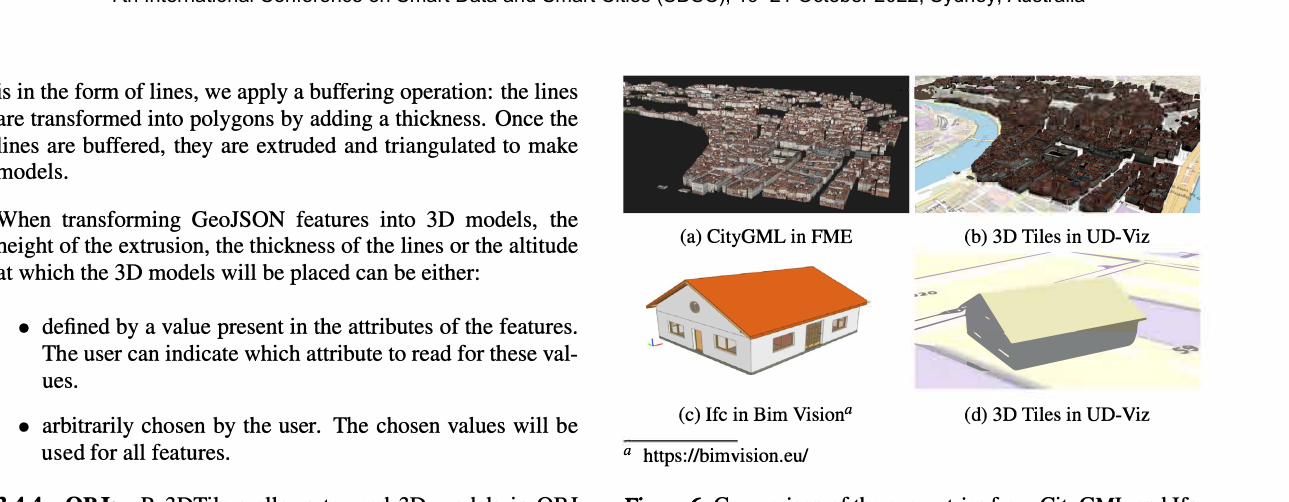
Figure 6. Comparison of the geometries from CityGML and Ifc with the geometries transformed as 3D Tiles